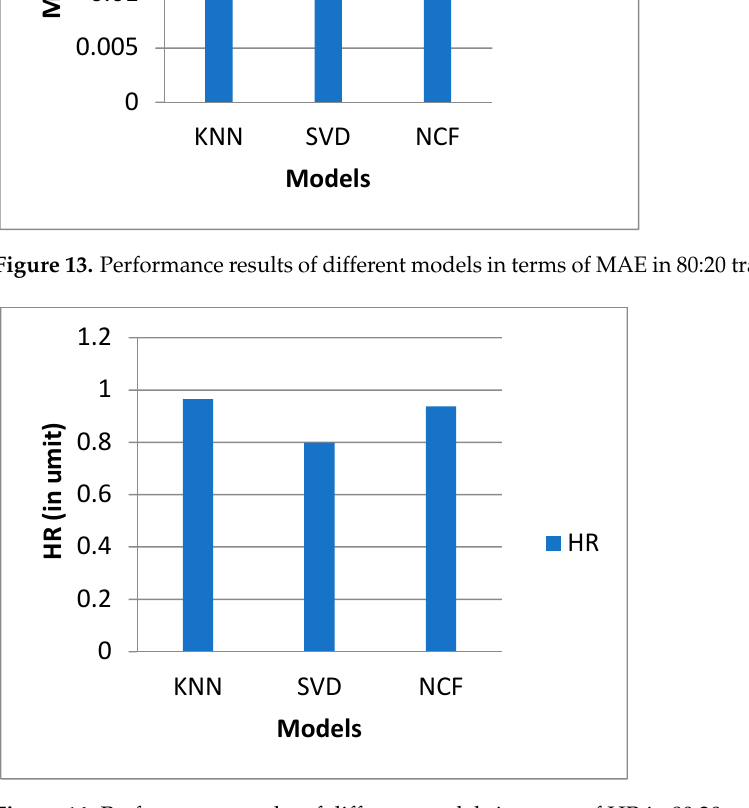
Figure 15. Performance results of different models in terms of ARHR in 80:20 training–testing scenario. Figure 16. Comparative results of different models in terms of MAE, HR and ARHR in 80:20 training–testing scenario. 4.2. Discussion From Tables 1–3 and Figures 5–16, it is observed that the MAE values (in units) of KNN, SVD and NCF in 60:40 training–testing scenarios are 0.0130, 0.0237 and 0.0156, respectively. The HR values (in units) of KNN, SVD and NCF in 60:40 training–testing scenarios are 0.875, 0.725 and 0.850, respectively. The ARHR values (in units) of KNN,